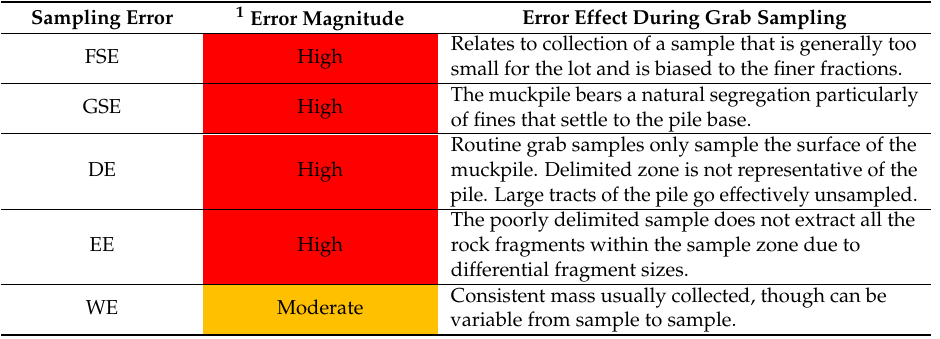
Table 17. Sampling errors and their impact on grab sampling.